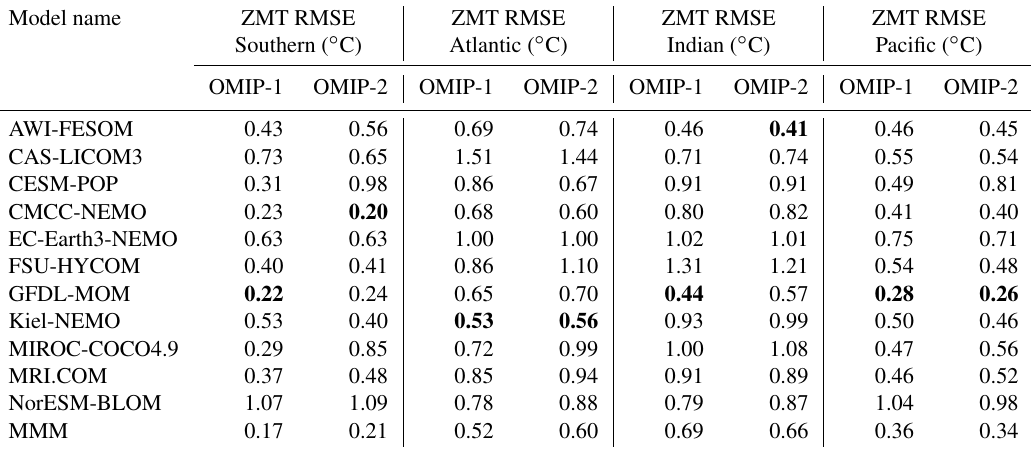
Table D5. Root mean square bias of the 30-year mean (1980–2009) basin-wide averaged zonal mean temperature ( ◦ C) relative to observations (WOA13v2) for individual models. The smallest root mean square bias values for models in each simulation are emphasized with bold